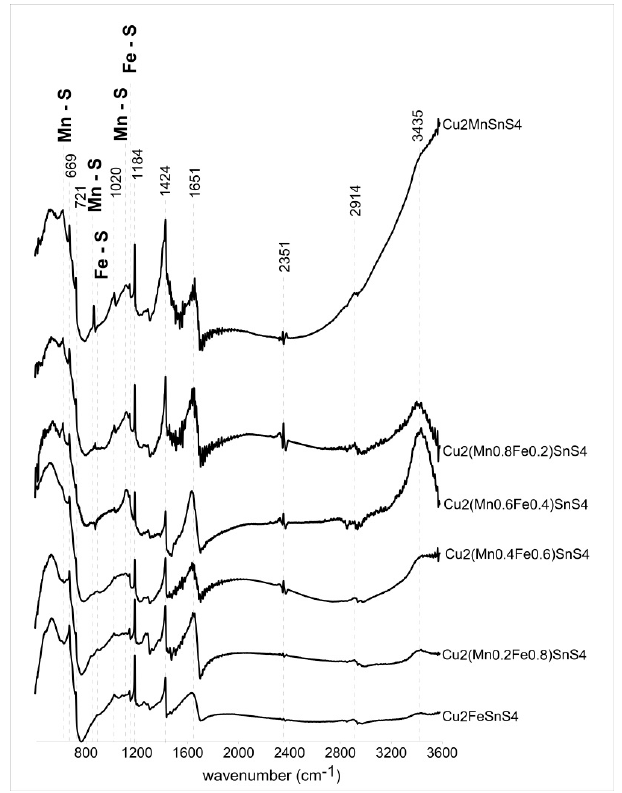
Figure 14. Fourier transform infrared spectra of Cu 2 (Mn 1 − x Fe x )SnS 4 solid solution series. Several bands do not come directly from the synthesis products, but are an artifact of a small amount of impurity coming from the unreacted components used in the experiments. Specific Mn–S vibrations (617, 860, 1114 cm − 1 ) and Fe–S vibrations (880 and 1142 cm − 1 ) are marked.